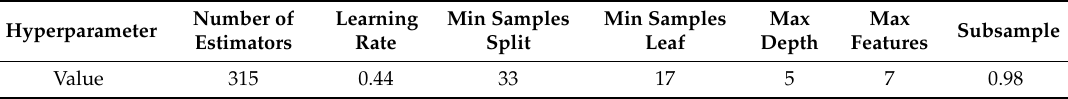
Table 6. Hyperparameters for the GBRT